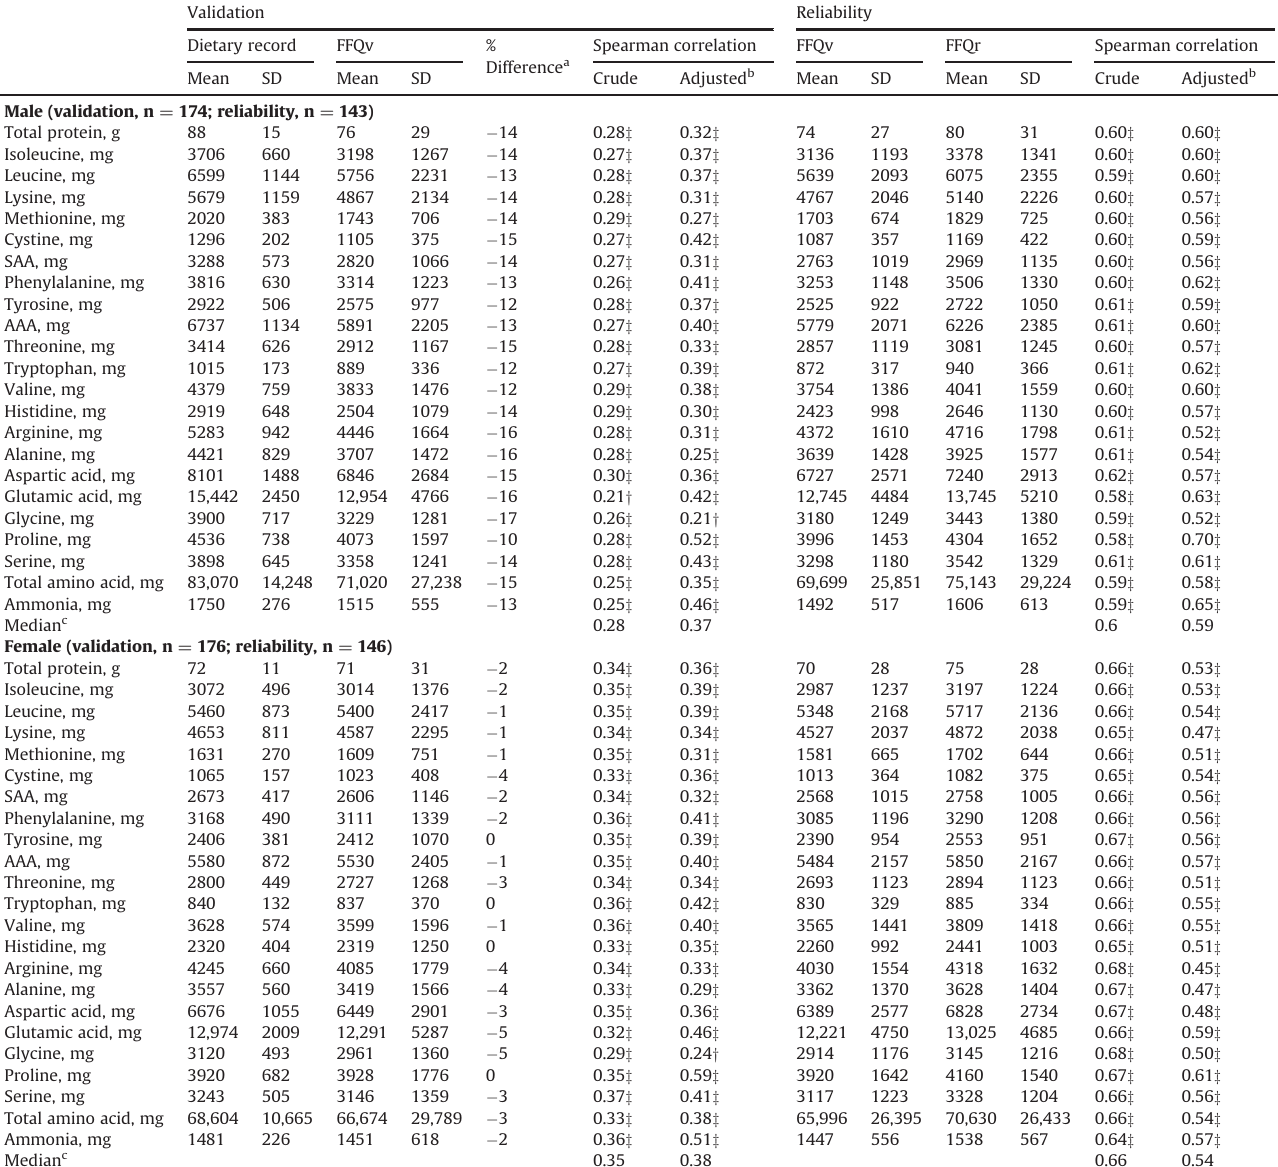
Table 2 Amino acid intakes calculated using dietary record for 28 days and food frequency questionnaires in Cohort II and their correlations.